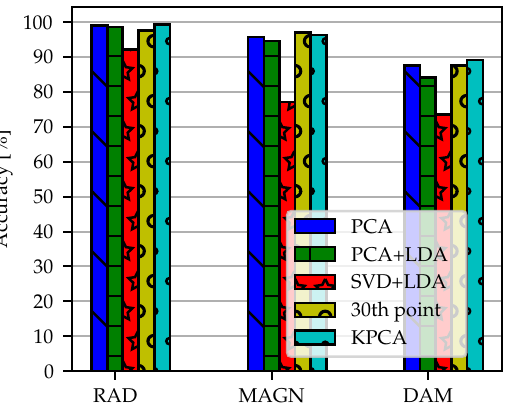
Figure 8. Comparison of dimensionality reduction methods for the models FC-OD-30thFreq-RAD/- MAGN/-DAM, FC-OD-PCA-RAD/-MAGN/-DAM, FC-OD-PCA+LDA-RAD/-MAGN/-DAM, FC- OD-SVD+LDA-RAD/-MAGN/-DAM and FC-OD-KPCA-RAD/-MAGN/-DAM. Accuracy calcu- lated with FC is shown. The dimensionality reduction methods are PCA, PCA+LDA, SVD+LDA, KPCA and using only every 30th data point. Angular position was omitted because there was no training effect at all.